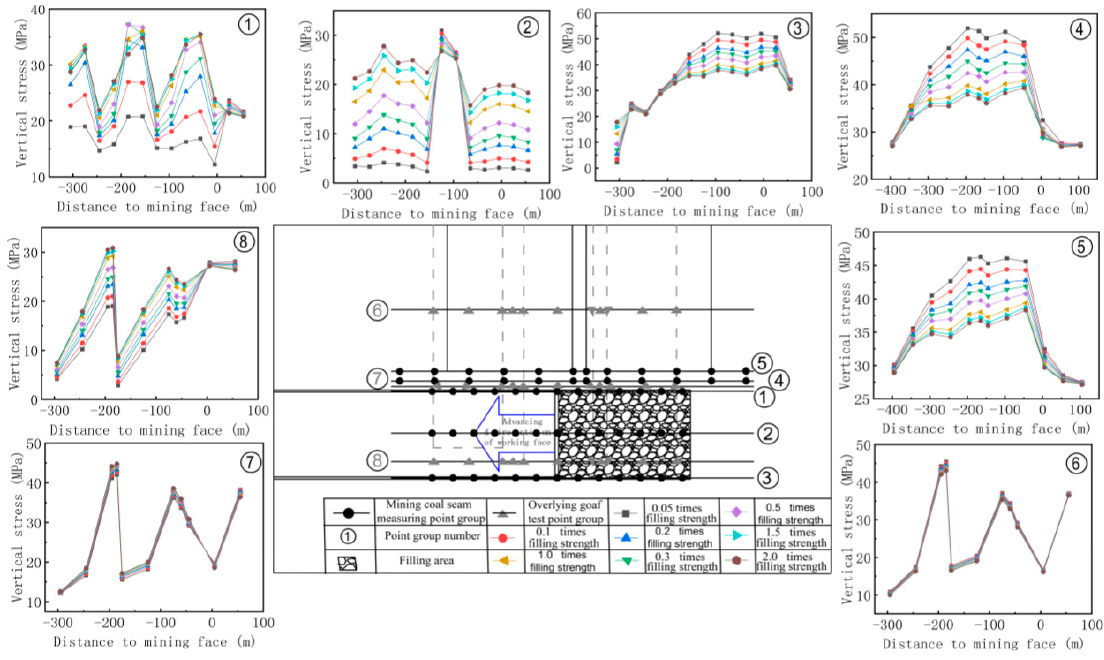
Figure A6. Distribution of the underground pressure (300 m).